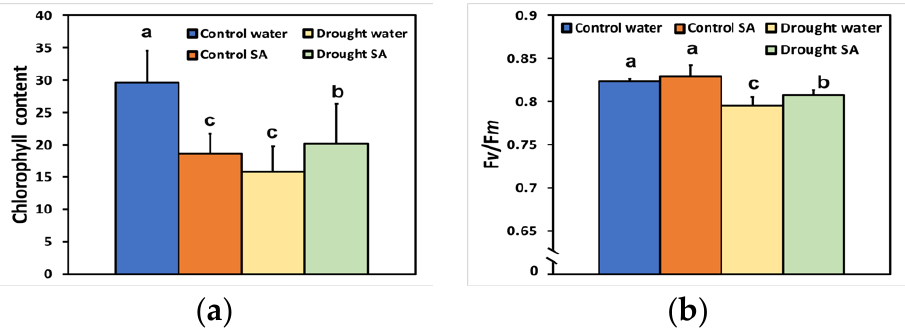
Figure 1. Chlorophyll content ( a ); and maximum efficiency of PSII photochemistry (F v /F m ) ( b ); of oregano seedlings grown under optimal conditions (control) or moderate drought stress (MoDS), and sprayed by 1 mM SA or H 2 O. Error bars represent standard deviations ( n = 4). Different lowercase letters represent statistical difference ( p < 0.05).